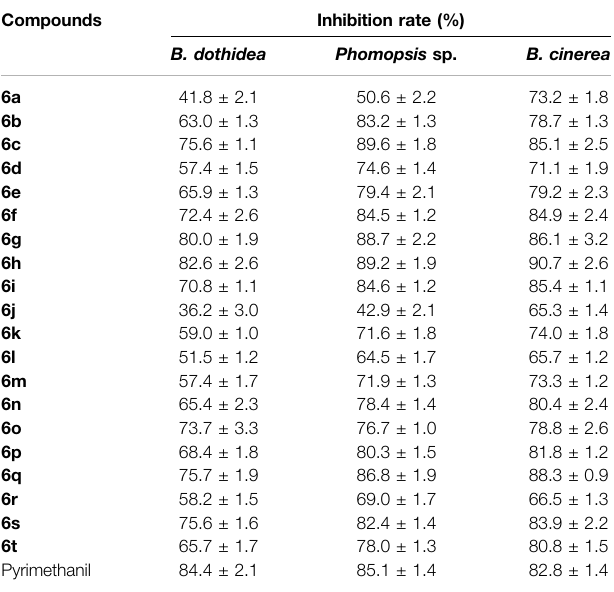
TABLE 1 | Inhibition rates of compounds 6a − 6t against B. cinereal , B. dothidea , and Phomopsis sp. at 50 µg/ml. Compounds